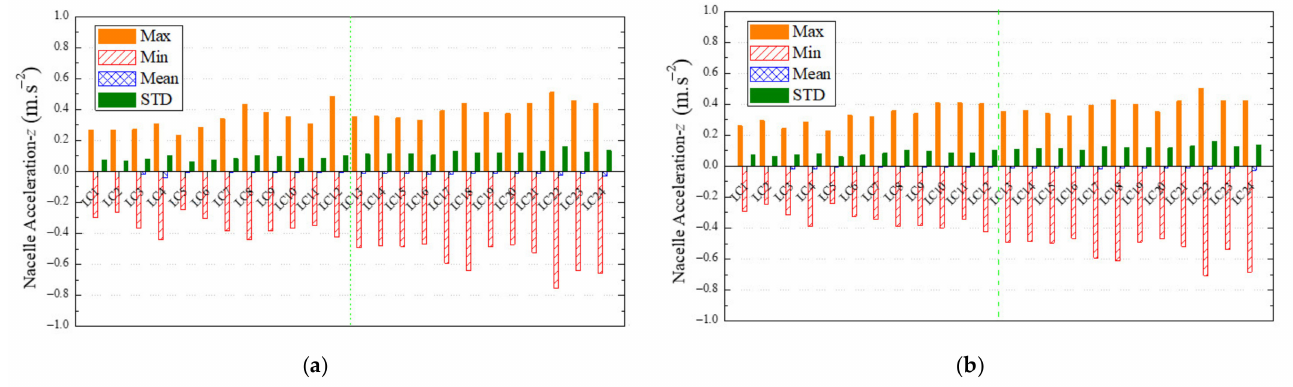
Figure 18. Statistics of nacelle acceleration response in y -direction for ( a ) without current; ( b ) with current.